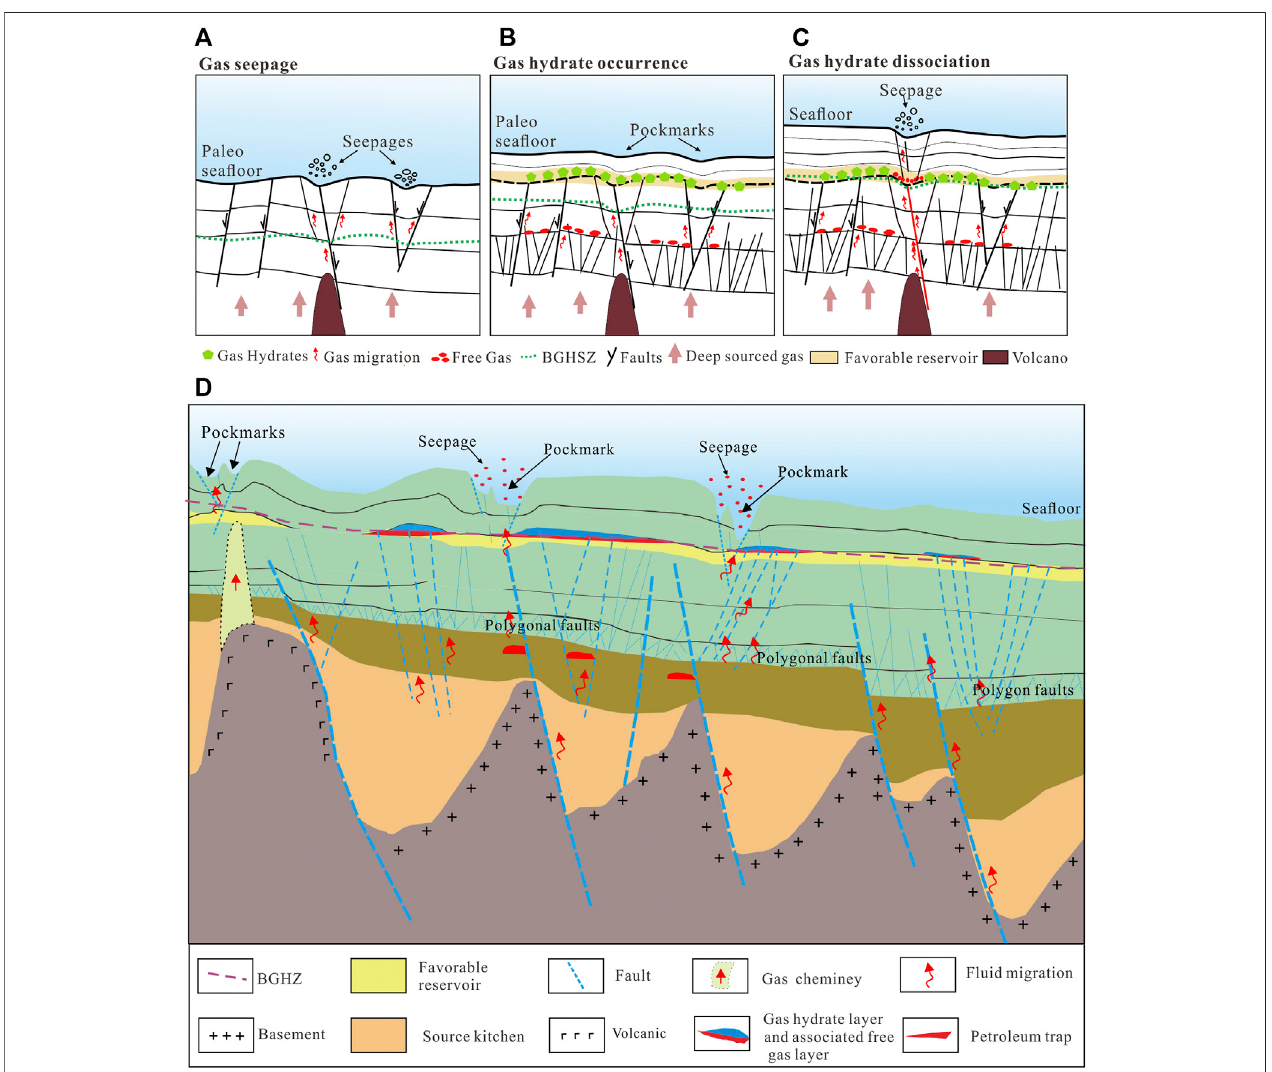
FIGURE 12 | (A) – (C) Conceptual model of development of pockmarks controlled by magmatic activity and gas hydrate dissociation below gas hydrate stability throughout heat fl ux or fault reactivation from the deep. The scenario is composed of three phases (A,B,C) . (D) Schematic model map in the study area of the Zhongjiannan basin showing the relationship among gas reservoir, polygonal faults, shallow gas accumulations, BSR, pockmarks, volcano, gas hydrates, and associated free gas.